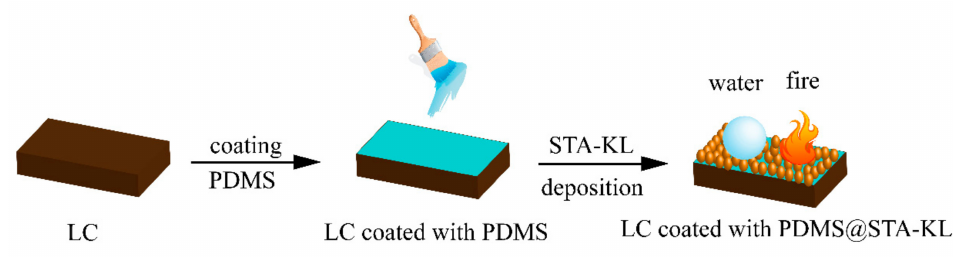
Figure 1. Schematic illustration of the procedure to fabricate Polydimethylsiloxane@stearic acid-kaolin (PDMS@STA-KL) coating on Lignocellulose composites (LC)